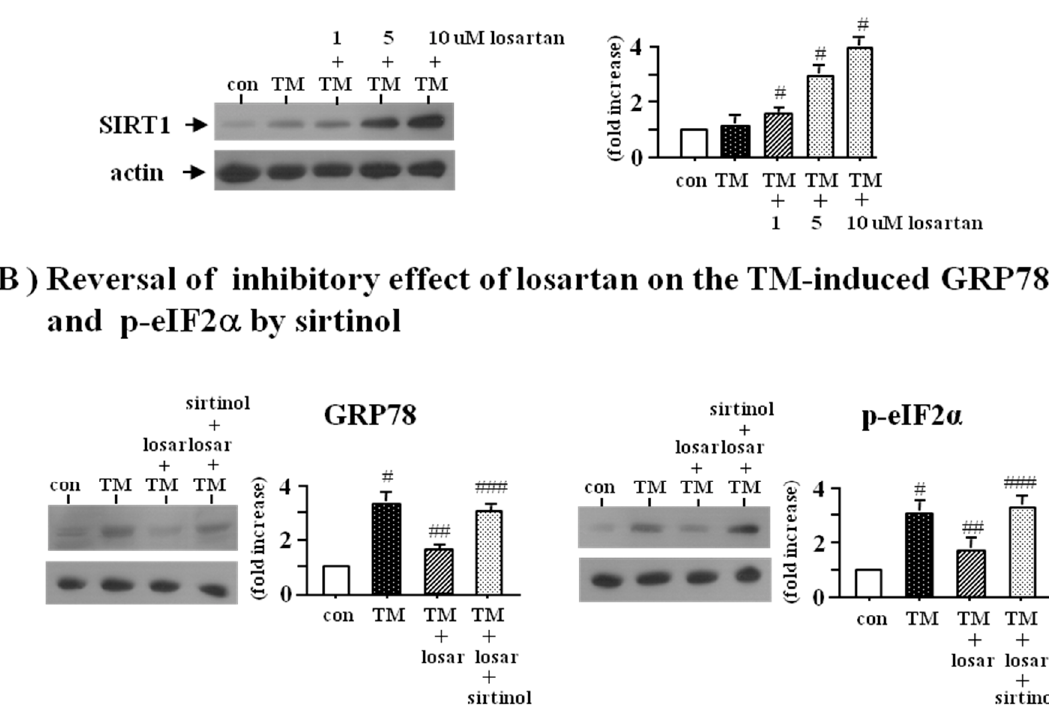
Figure 2. Induction of SIRT1 (silent mating type information regulation 2 homolog 1) by losartan ( A ) and reversal of inhibitory effect of losartan on the tunicamycin-induced ER stress by sirtinol ( B ). Proximal tubular cells were incubated with tunicamycin (TM, 0.2 µM) with or without losartan (losar, 1–10 µM) for 24 h. Expression of SIRT1 was examined by Western blot analysis ( A ); Proximal tubular cells were incubated with tunicamycin (TM, 0.2 µM) with or without losartan (losar, 10 µM) and sirtinol (SIRT1 inhibitor, 10 µM) for 24 h. Expression of GRP78 and p-eIF2 α was examined by Western blot analysis ( B ). The relative densities of the bands for SIRT1, GRP78, and p-eIF2 α were normalized to those for actin for standardization. Representative blots and quantitative analysis from three independent experiments were shown. Results were expressed as n -fold increase over control as mean ± S.E. #: p < 0.05 vs. con (control); ##: p < 0.05 vs. TM; ###: p < 0.05 vs. TM + losar.